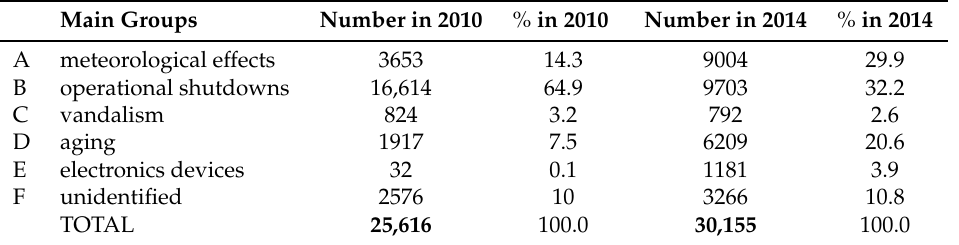
Table 1. The number and main reasons for electrical transmission network failures in southern Poland in 2010 and January–July